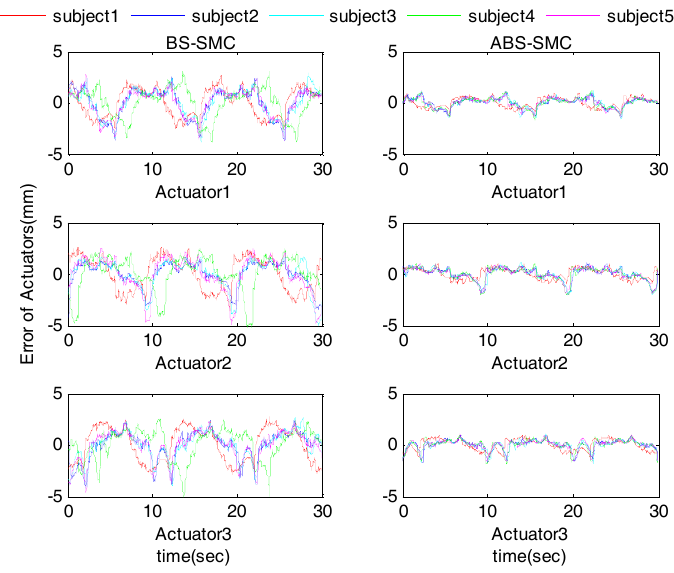
Figure 10. Actuator tracking error results with five subjects. Table 4. Statistical analysis of actuator position tracking errors under different control methods (with five subjects).